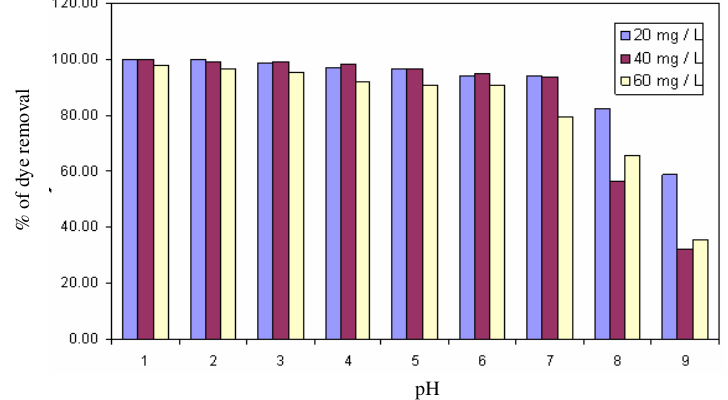
Figure 1. Effect of pH on % of dye